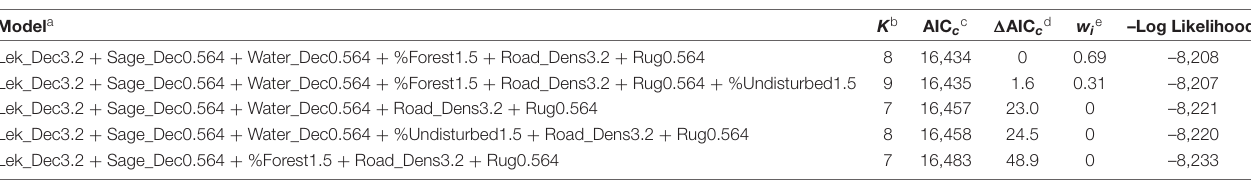
TABLE 2 | Models for spring/summer resource selection function. Model